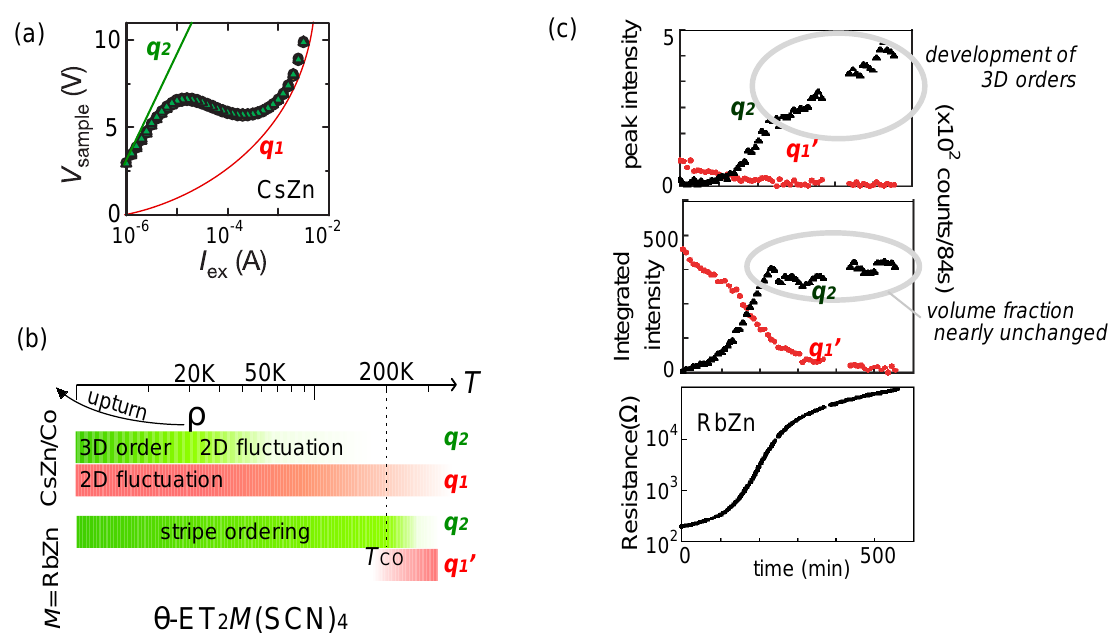
Figure 20. ( a ) IV characteristics of θ -ET ( b ) Low temperature characters of the q Time evolution of the X-ray intensities (peak and integrated ones) measured simultaneously with the resistivity, adapted with permission from [86], copyrighted by the Physical Society of